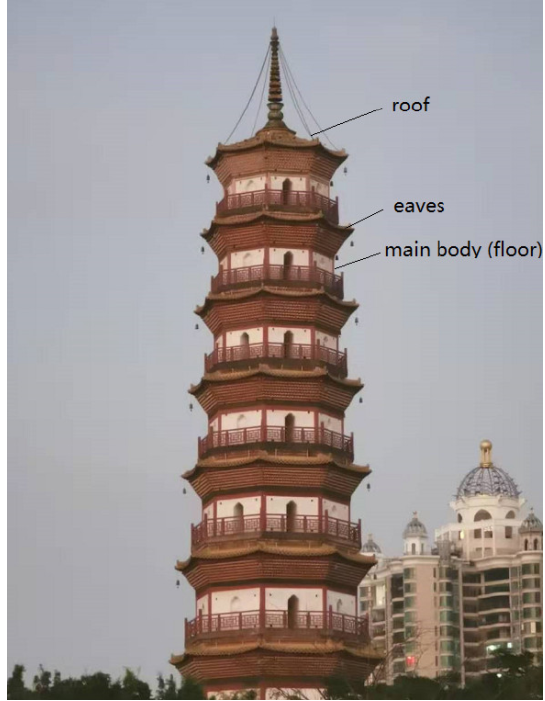
Figure 2. A typical polygonal pagoda in China (Chigang Pagoda,